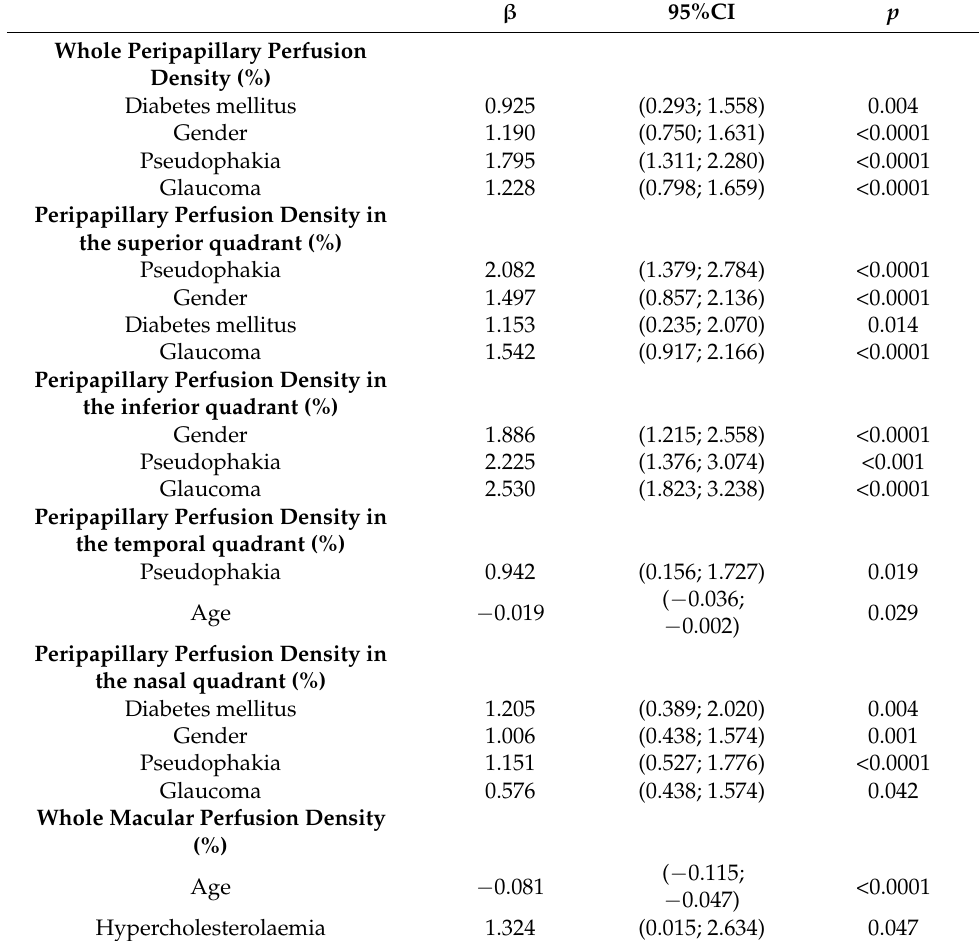
Table 4. Linear regression analysis to evaluate the effect of glaucoma, SAH, HC and DM diagnosis and the most relevant demographic and clinical data on sPVD and sMVD. β